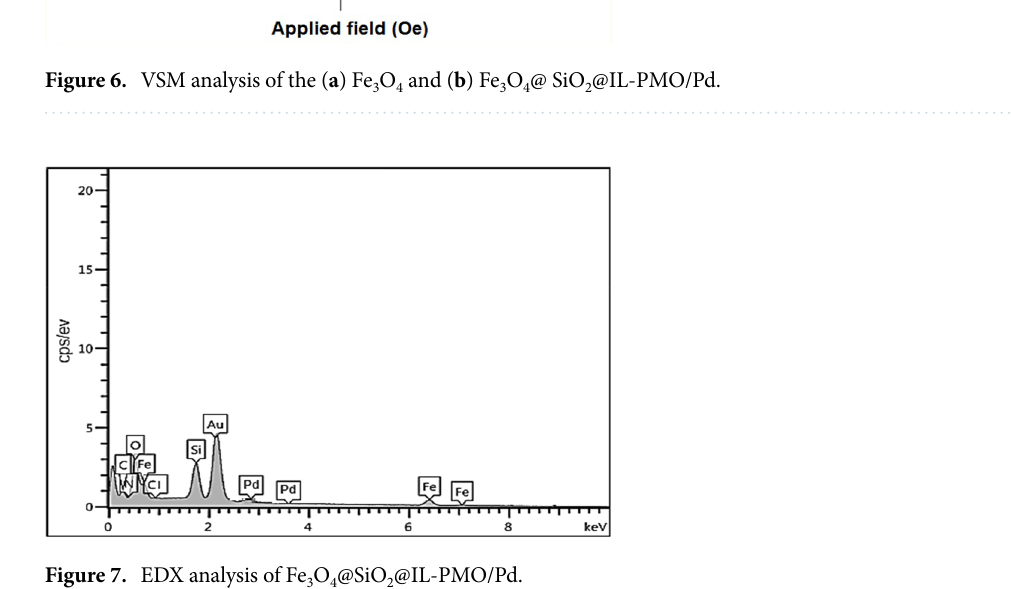
Figure 7. EDX analysis of Fe 3 O 4 @SiO 2